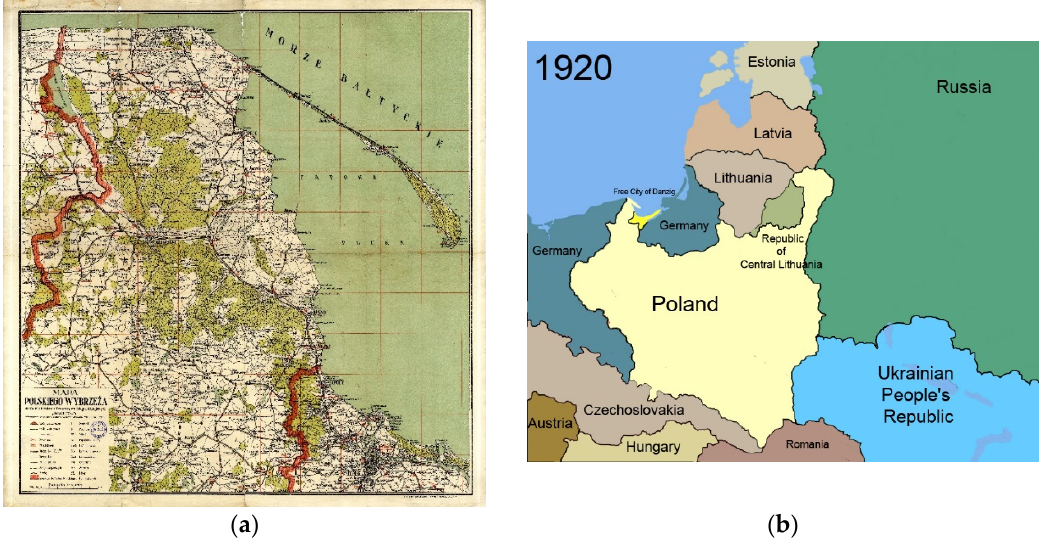
Figure 5. Map of the Polish coast (1930) and borders of Poland in 1920. Source: Mapster ( a ); Esemono (Public domain) Wikimedia Commons, the free media repository ( b ).